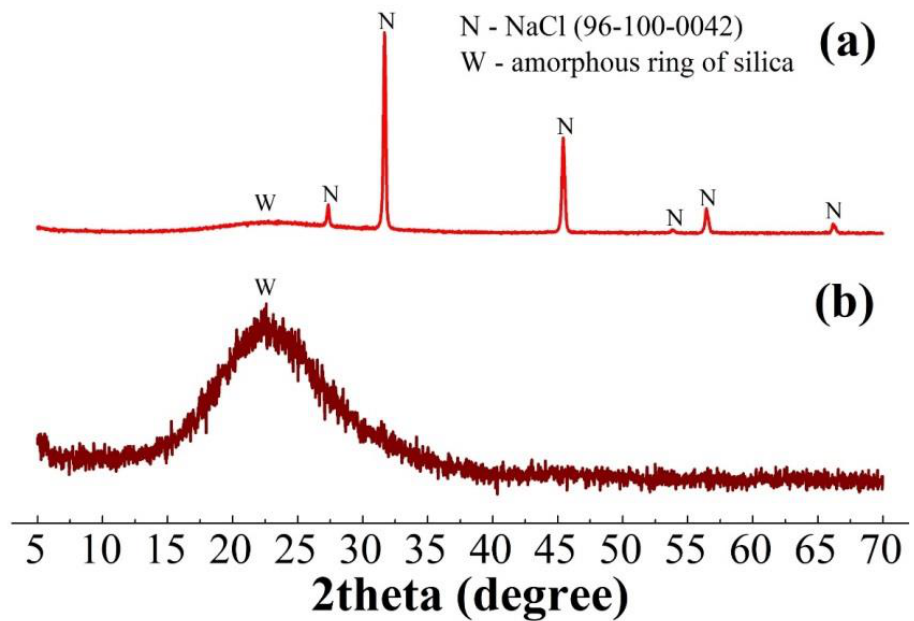
Figure 15. The XRD patterns of white carbon precipitated from silicate solution precipitation using 20% HCl before ( a ) and after ( b ) following water washing.